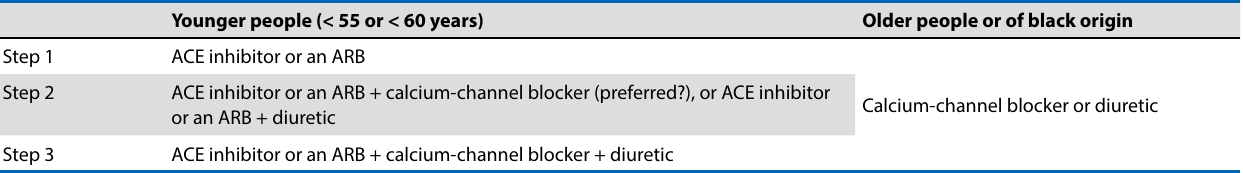
Table I: Guideline recommendations on the use of angiotensin-converting enzyme inhibitors and angiotensin-specific receptor blockers in the treatment of hypertension Younger people (< 55 or < 60